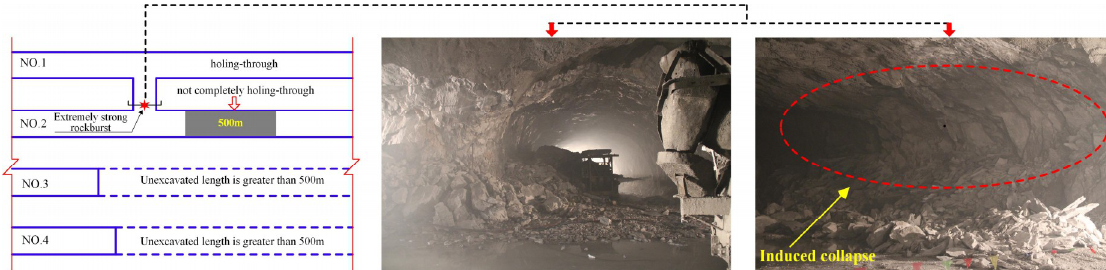
Figure 14 . Rockburst in cross passage. Figure 14. Rockburst in cross